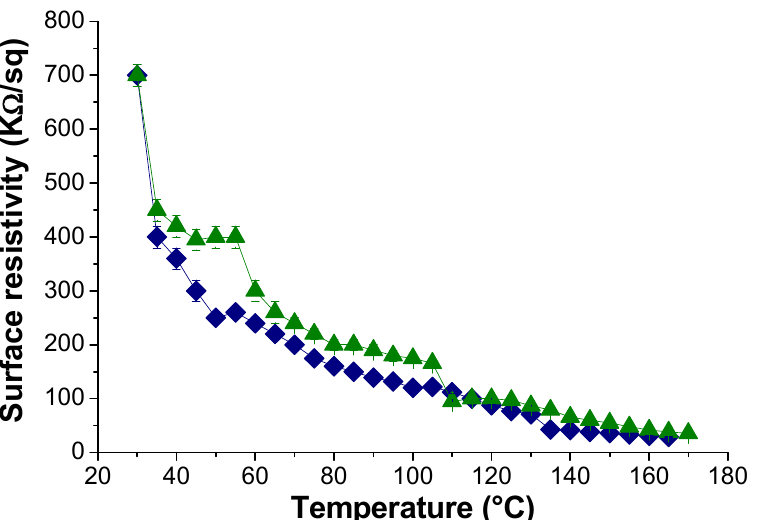
Figure 10. Resistivity of the nanocomposite composed by PK30-Gly-Gly and hrGO at different temperatures. 5 ( ♦ ) and ( ▲ ) 6 wt. % of filler concentration.